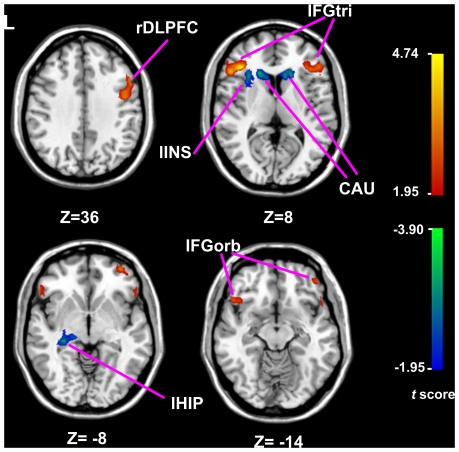
T-statistical map of the resting-state brain activity levels between the adolescents with MDD and HCs.The color-coded t-score bars indicated increased (warm color) ALFF and decreased (cold color) ALFF in the MDD patients relative to HCs. The voxels with p<0.03 and a cluster size of >179 were used to identify the clusters with significant differences; these criteria met a threshold of p<0.05 (corrected for multiple comparisons). The details of these regions were presented in Table S1.